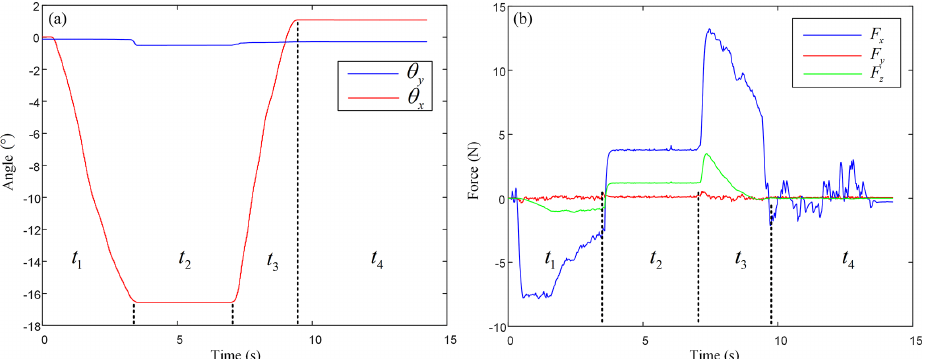
Figure 15. Helicopter take-off stage control process. (a) Operating conditions of the haptic interface; (b) calculation results.